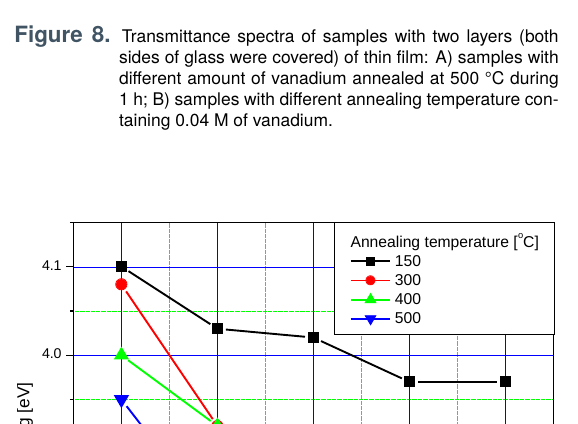
Fig.8. Transmittance spectra of samples with two layers (both sides of glass were covered) of thin film: A – samples with different amount of vanadium annealed at 500 o C during 1h; B – samples with different annealing temperature containing 0.04 M of vanadium.